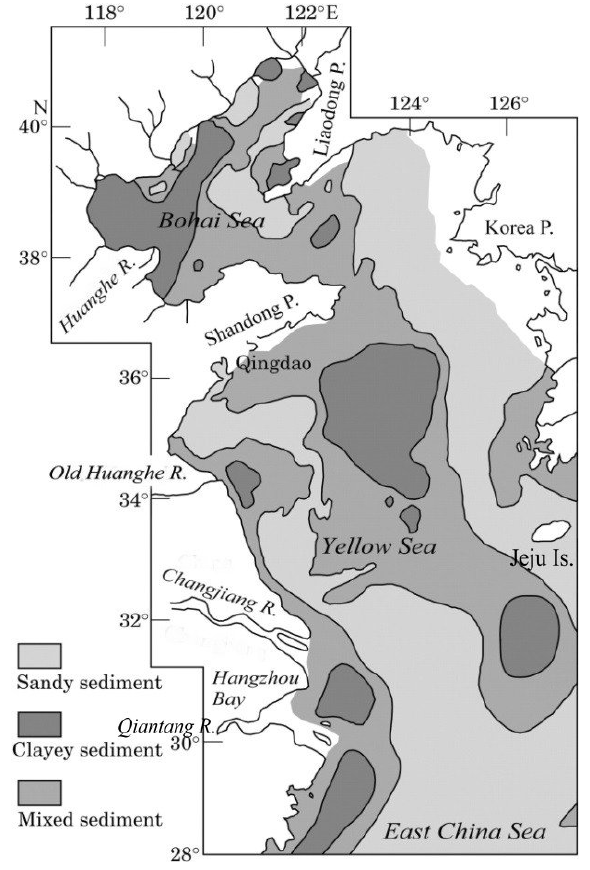
Figure 2. The main bottom sediment types and their distribution patterns in the ECS (modified from Zhu and Chang, 2000 [42]).